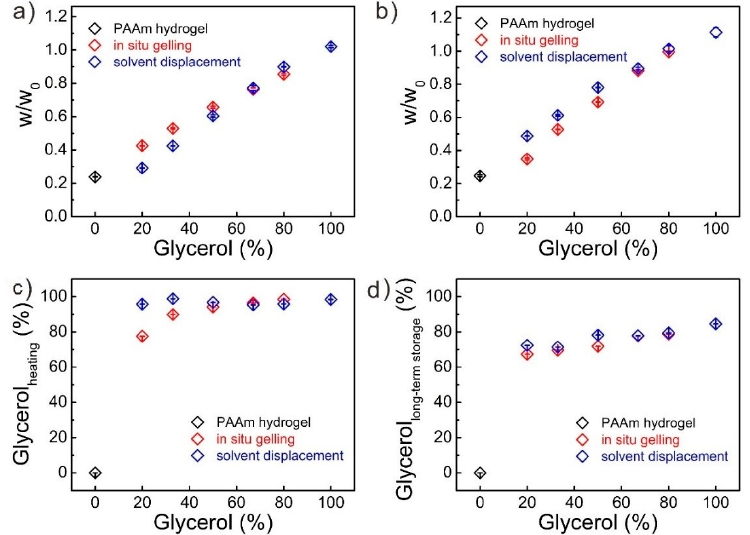
Figure 4. The antiheating and antidehydration investigations of the PAAm gels from both strategies. ( a , b ) The remaining weight ratios of the PAAm gels with di ff erent glycerol contents after ( a ) heating in the 60 ◦ C oven for 24 h and ( b ) storing at room temperature with low humidity (25 ◦ C and 50% humidity) for 15 days. ( c , d ) The calculated glycerol content in the remaining PAAm gels after ( c ) heating and ( d ) long-term storing treatments.